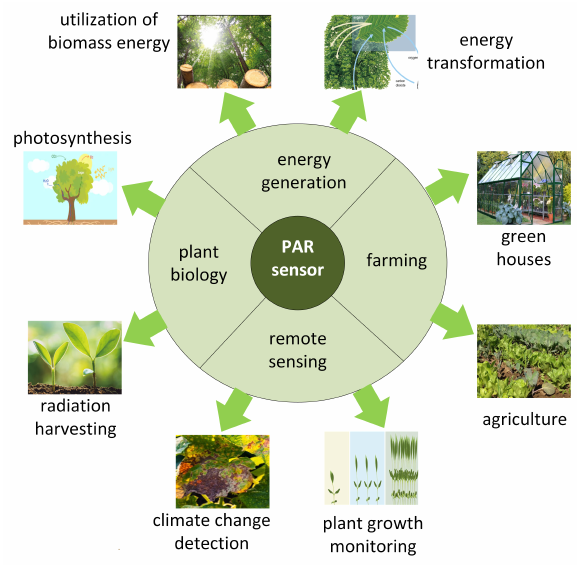
Fig. 1. Application areas for PAR sensors.